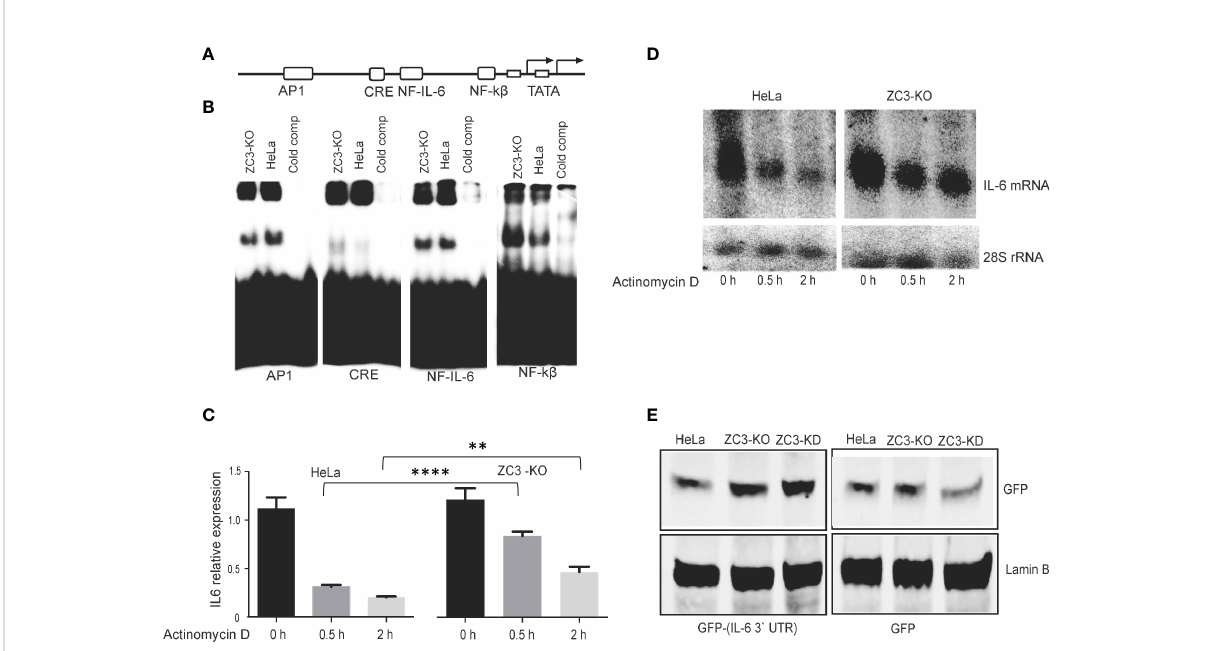
FIGURE 4 Mechanism for IL-6 mRNA overexpression in ZC3-KO cells. Schematic drawing of the transcription factor binding sites in the IL-6 promoter (A) . Nuclear extracts were prepared from HeLa cells or ZC3-KO cells treated with IL-1ß (10 pg/ mL) for 4 hrs. Extracts were incubated with 32P- labeled double-stranded oligonucleotides corresponding to the transcription factor binding sites depicted in panel A (Table S1). Complexes were resolved on a neutral agarose gel, dried and visualized on a Fuji PhosphorImager. In lanes labeled “ cold comp ” the ZC3-KO extract was incubated with a 10-fold excess of the corresponding unlabeled oligonucleotide (B) . HeLa cells or ZC3-KO cells stimulated with IL-1ß for 30 min were treated with actinomycin D and samples collected at 0 h, 0.5 h, and 2 h after actinomycin D addition. Total cytoplasmic RNA was isolated and the effect of actinomycin D on IL-6 mRNA stability were quantitated by RT-qPCR, the data are presented as the mean ± SEM values. **P < 0.01; ****p < 0.0001; in unpaired t test (C) and visualized by northern blot. 28S rRNA accumulation served as loading control in the northern blot assay (D) . A GFP reporter containing the IL-6 3 ’ UTR was constructed and transfected to HeLa wild type, HeLa-KO or HeLa-KD cells. The expression of GFP from the GFP control plasmid and the GFP-IL-6 3 ’ UTR plasmid was visualized by western blot (E)